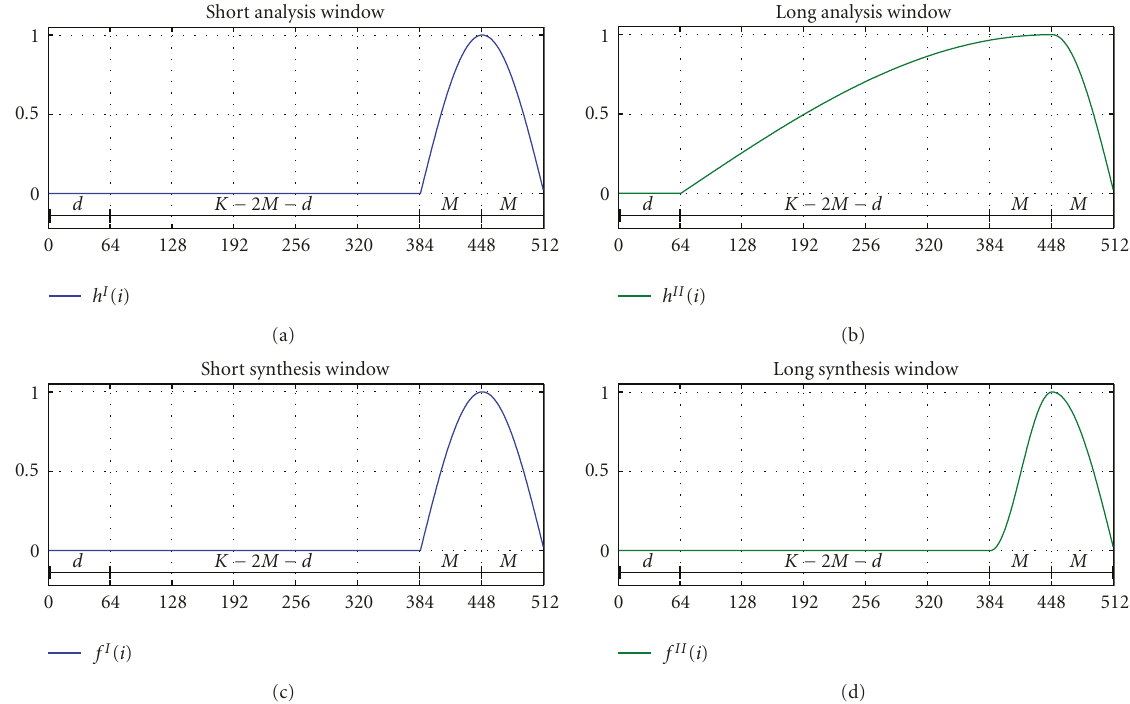
Figure 1: Example for a low delay switchable analysis-synthesis window set guaranteeing perfect reconstruction. The window pair in the left column has good temporal resolution while the pair in the right column provides a good spectral resolution. The asymmetry of the long analysis window emphasizes most recent